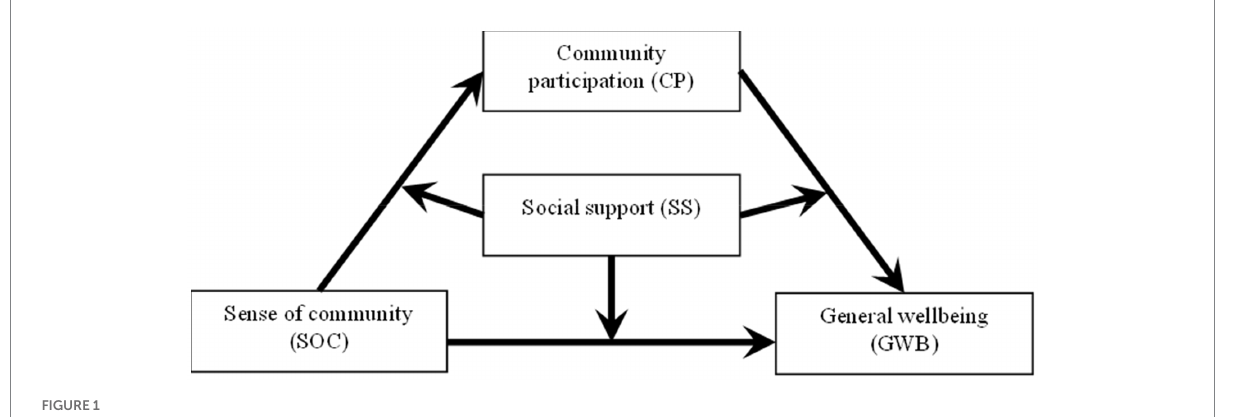
FIGURE 1 Conceptual